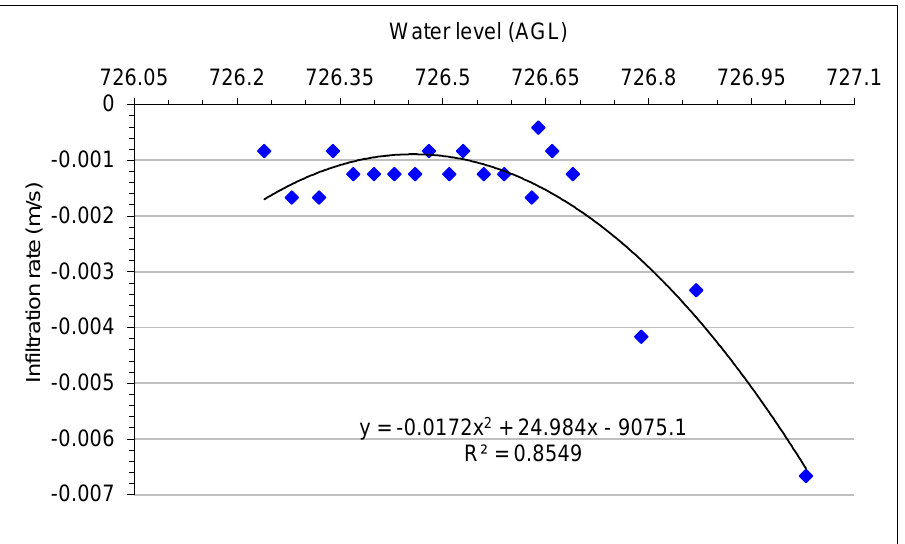
Figure 41. Variation of the infiltration speed depending on the water level of the lake at Hammam-Grouz dam, Algeria This representation indicates that the rate of infiltration increases with the rise of water in the